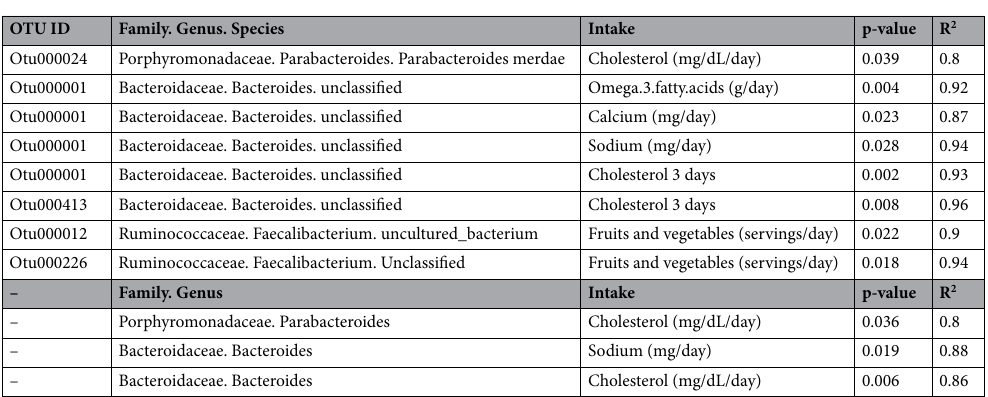
Table 1. Association between microbiome abundance at the species (top) or genus (bottom) level and nutrient intake concentration averaged over the 3 days prior to the biological collection. Three days has previously been shown to be adequate for dietary evaluation in relation to the microbiome 24